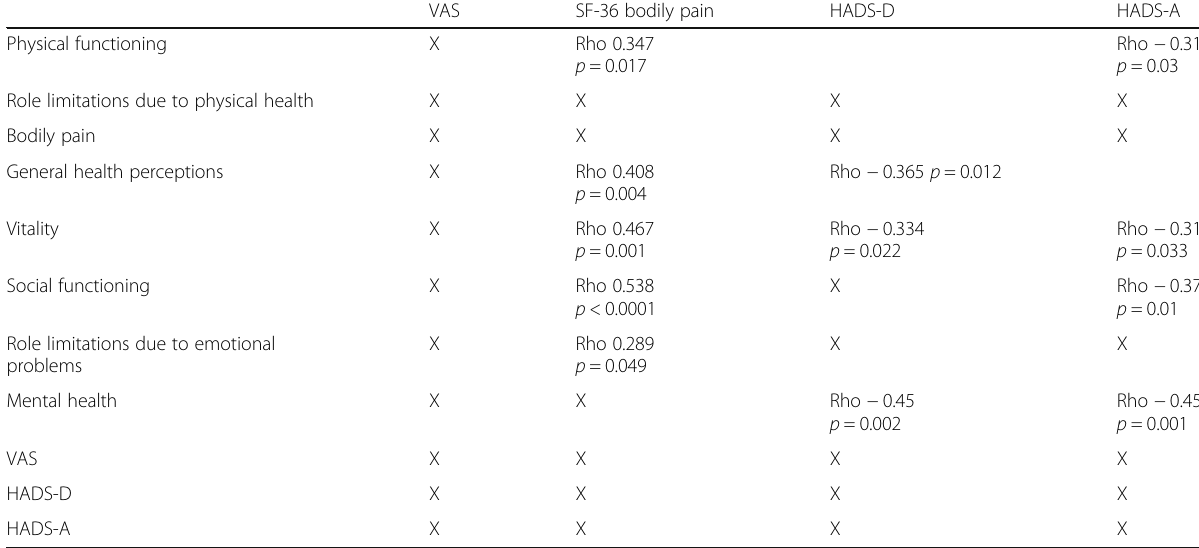
Table 2 Correlation among VAS, HADS, and SF-36 domains scores before spinal